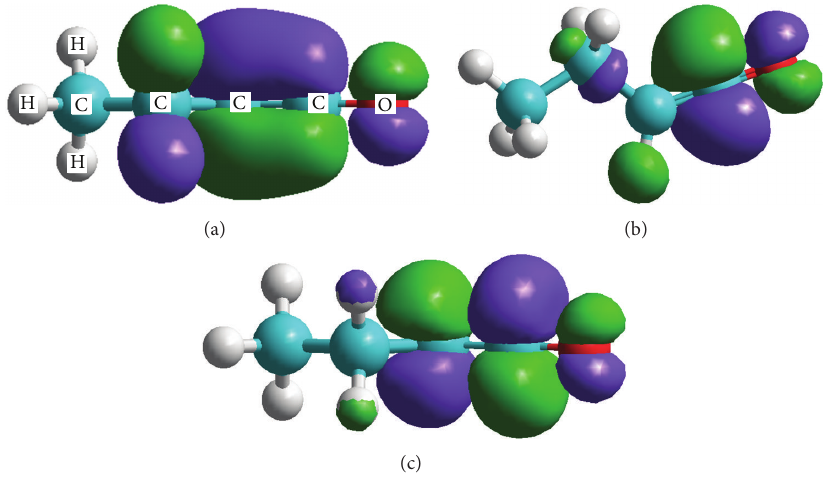
Figure 1: Frontier orbital of alkyl ketene. (a) HOMO; (b) LUMO; (c) LUMO-1.